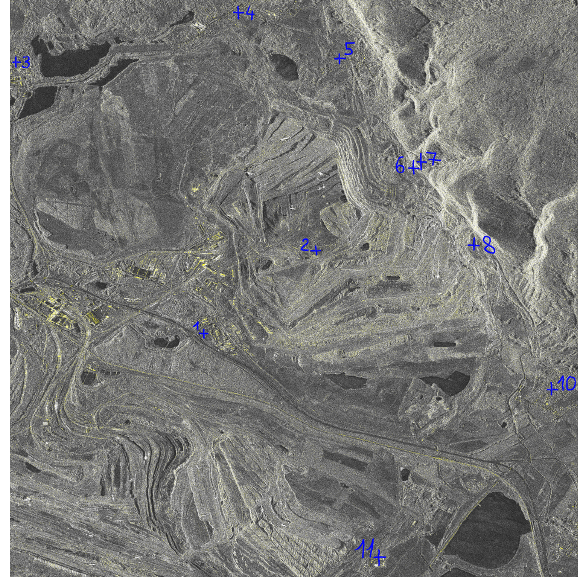
Figure 2: A map of the artificial reflectors in the scene crop (smaller than in figure 1) Corner reflector no. 9 is not visible in the radar image due to its position in the radar layover. Original data c (cid:13)